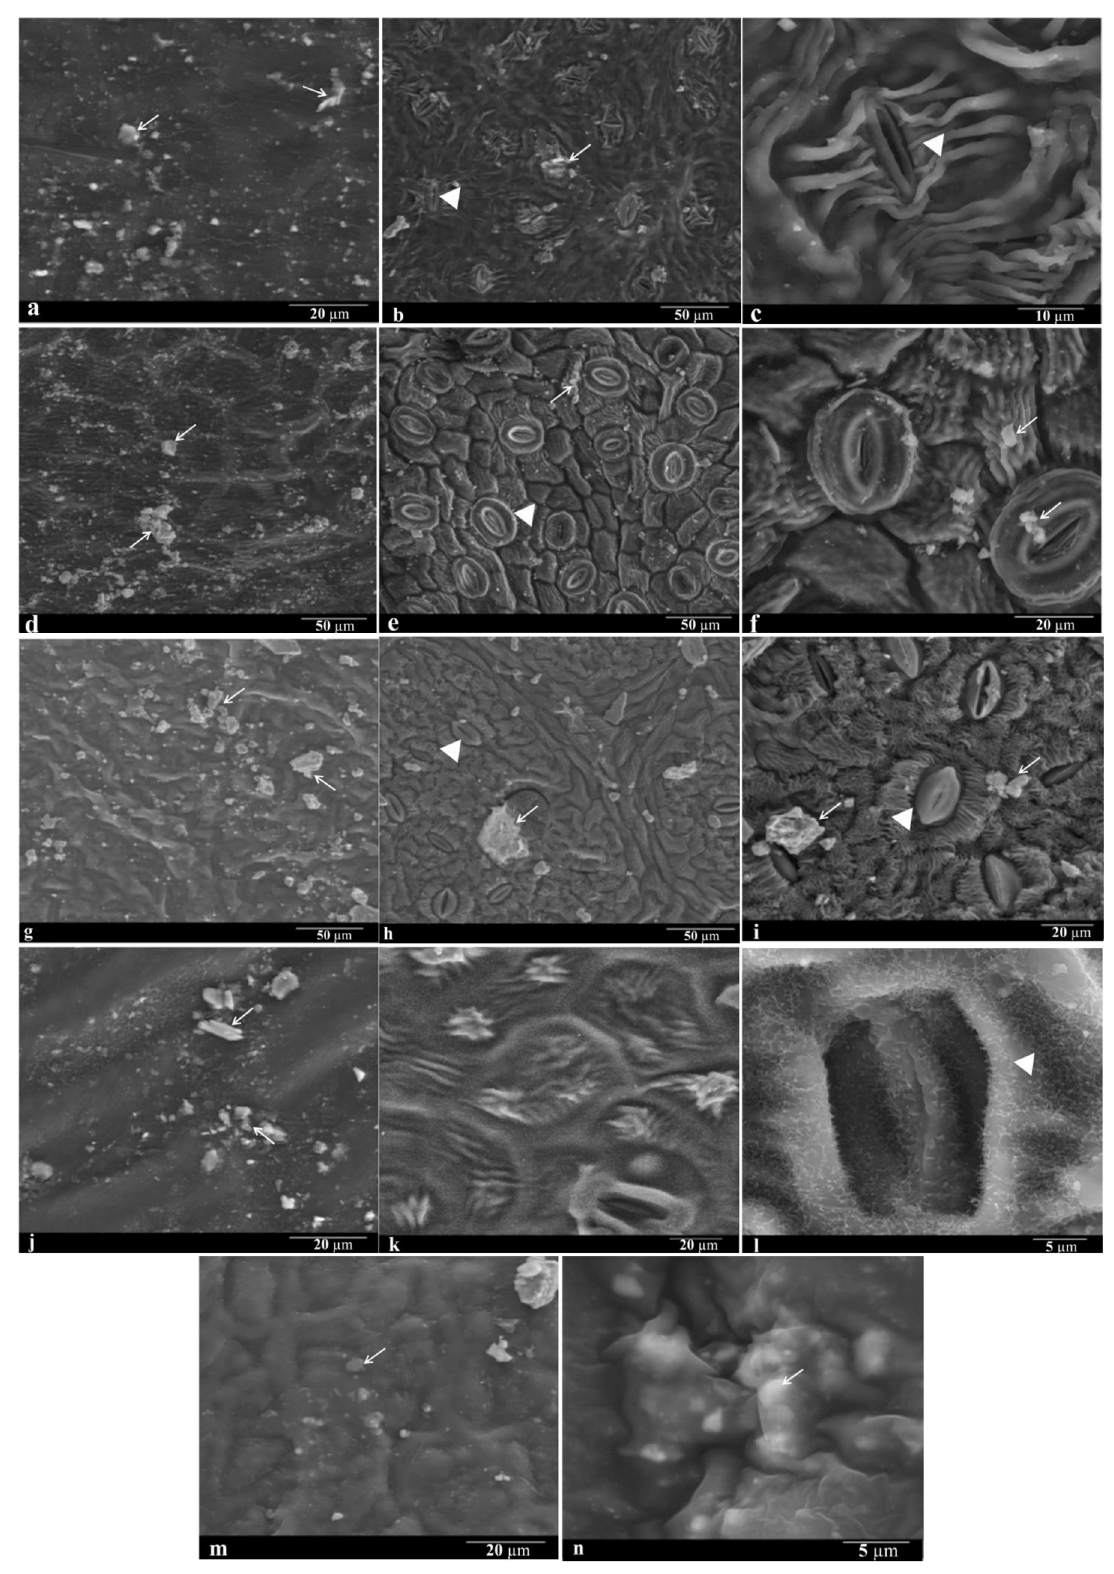
Figure 2. Scanning electron microscopy images of Populus tomentosa ( a – c ), ( d – f ), ( g – i ), and ( j – l ). a , d , g , j , m , and n , the upper side; b , e , h , and k , the lower side; c , f , i , and l , stomata. Particulate matter embedded in leaf epidermis ( m : Fraxinus chinensis ; n : Ginkgo biloba ). Symbols indicate examples of stomata (triangle) and particulate matter (arrow).